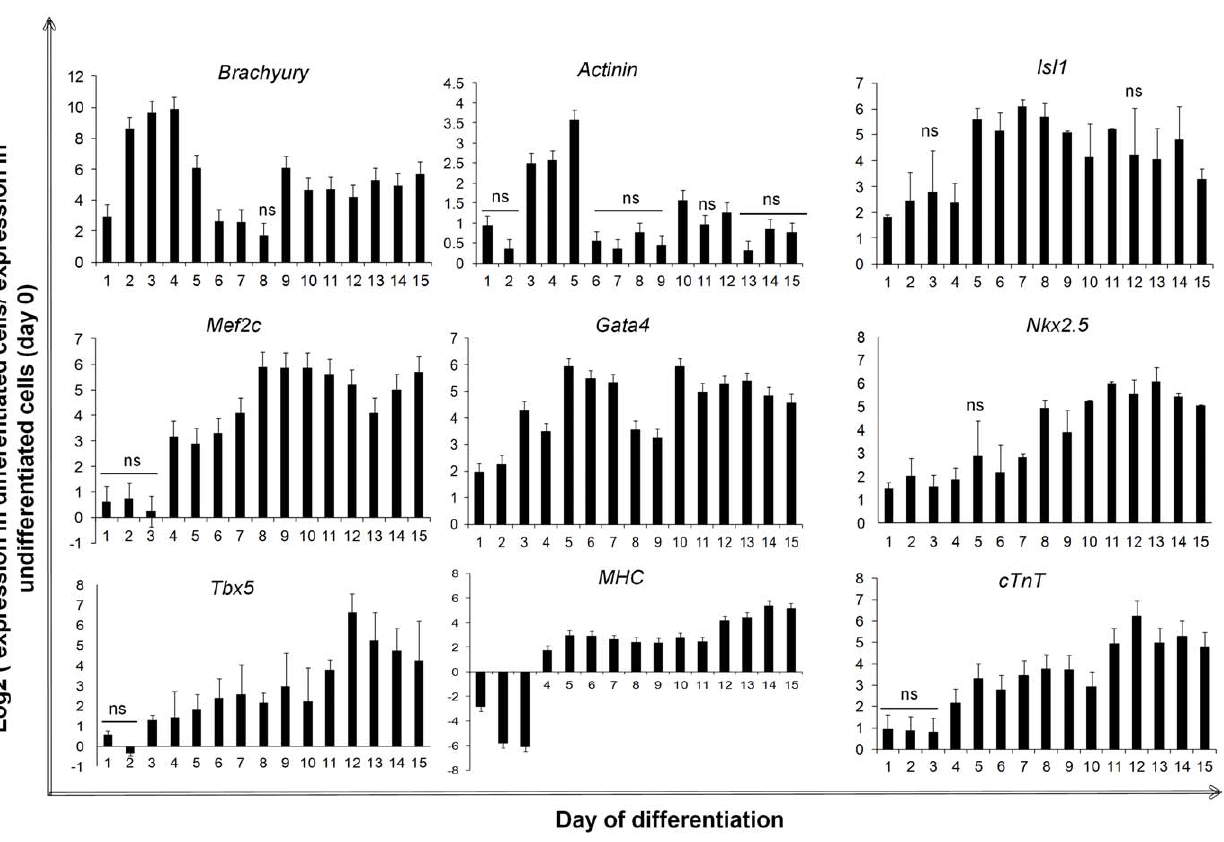
Figure 1. Daily qRT-PCR analysis in aggregate differentiation of hESCs. Undifferentiated aggregates of hESCs were treated by Activin A for 1 day and then for 4 days by BMP4. At day 5, the aggregates were plated without cytokines. The data show the maximum expression of the mesoendodermal marker, Brachyury , one day after Activin A treatment (day 2 after differentiation initiation). By continuing differentiation with BMP4 for the next 4 days Isl1 , a marker of precardiac mesoderm, and Actinin were reached to their highest expression level. Isl1 expression was remained at high level for the next 3 days and by decreasing its expression, Mef2c , a cardiac progenitor marker showed its maximum expression and after that, other cardiac progenitor genes, Gata4 Nkx2.5 and Tbx5 reached to their highest expression level respectively. Finally, the expression of MHC and cTnT , which are structural cardiomyocytes markers, got to maximum level (Fig. 1). These data shows that 3-dimentional structures of the cells are very important for cardiac differentiation and aggregated differentiation method enhances cardiac differentiation and functionality.Target genes were normalized by the reference gene Gapdh . The relative expression was calculated by dividing the normalized target gene expression of the treated sample with that of the undifferentiated state (day 0). All data represented as log2-linear plots. All data are statistically significant otherwise marked with ‘‘ns’’ (P . 0.05).